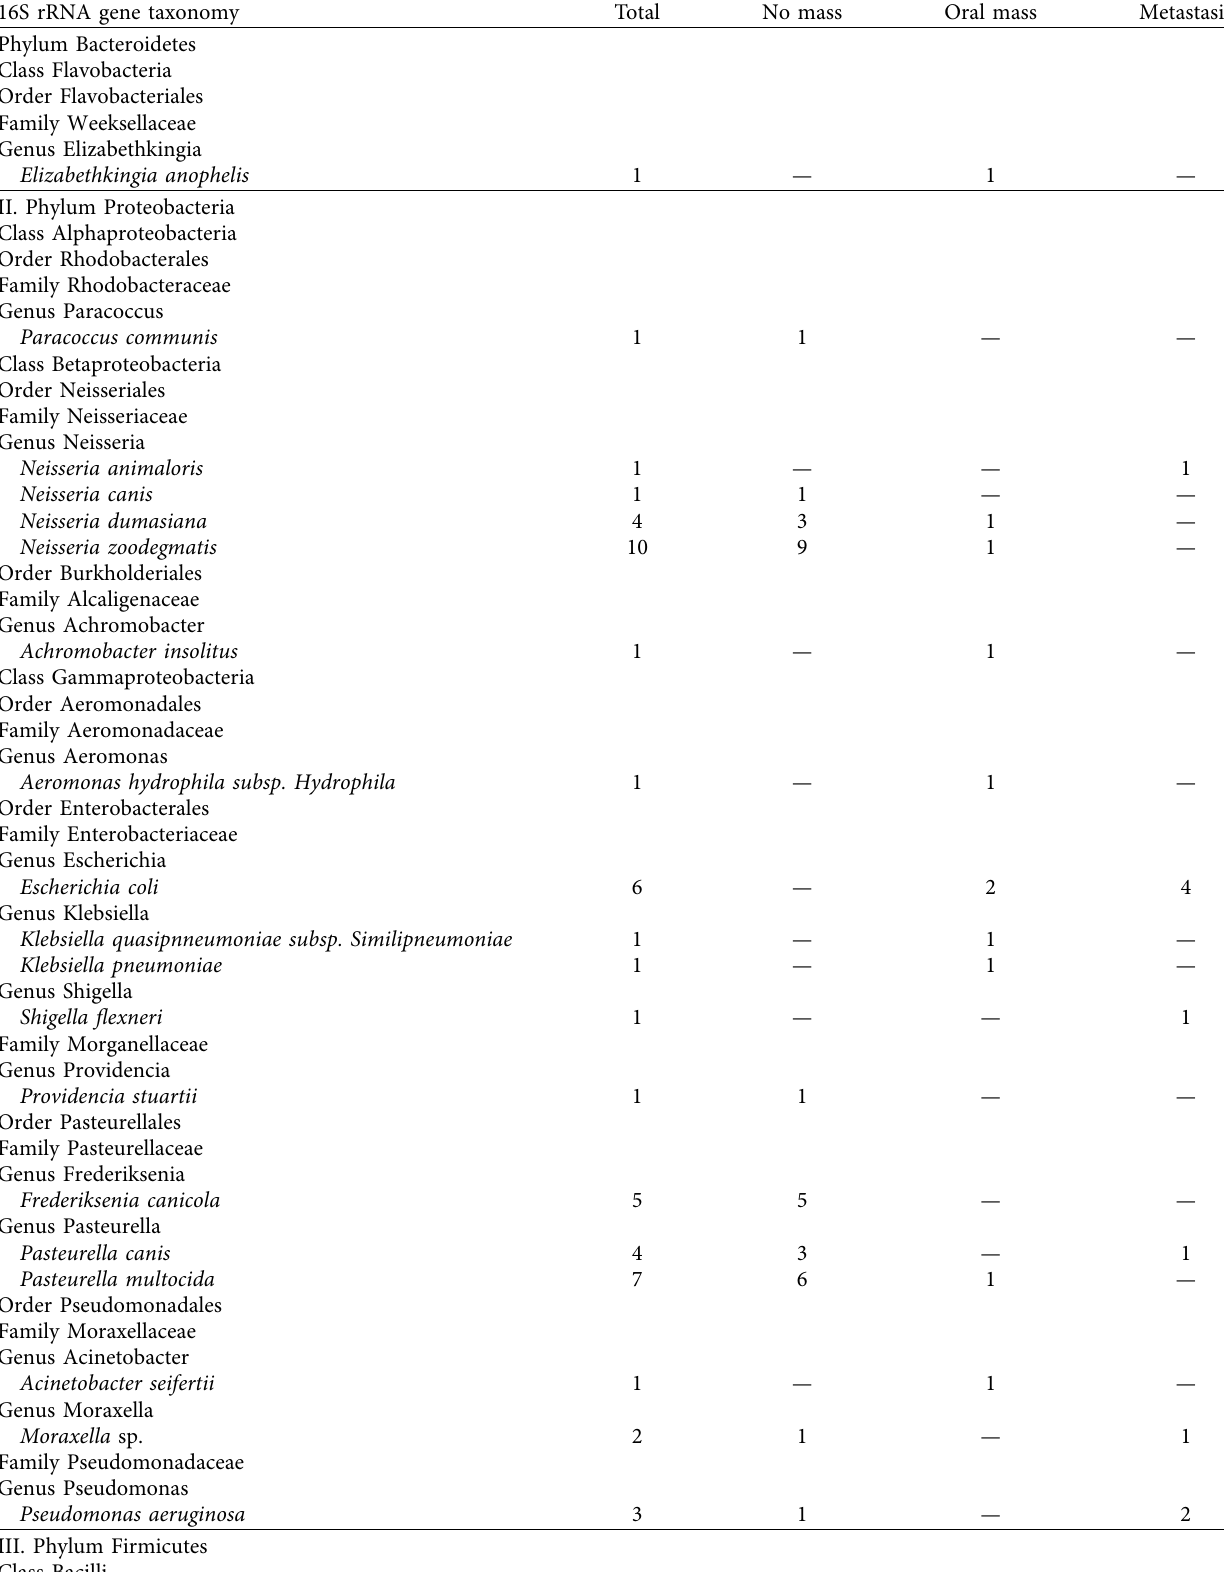
Table 7: Te bacterial identifcation with 16S rRNA gene taxonomy from the dog oral